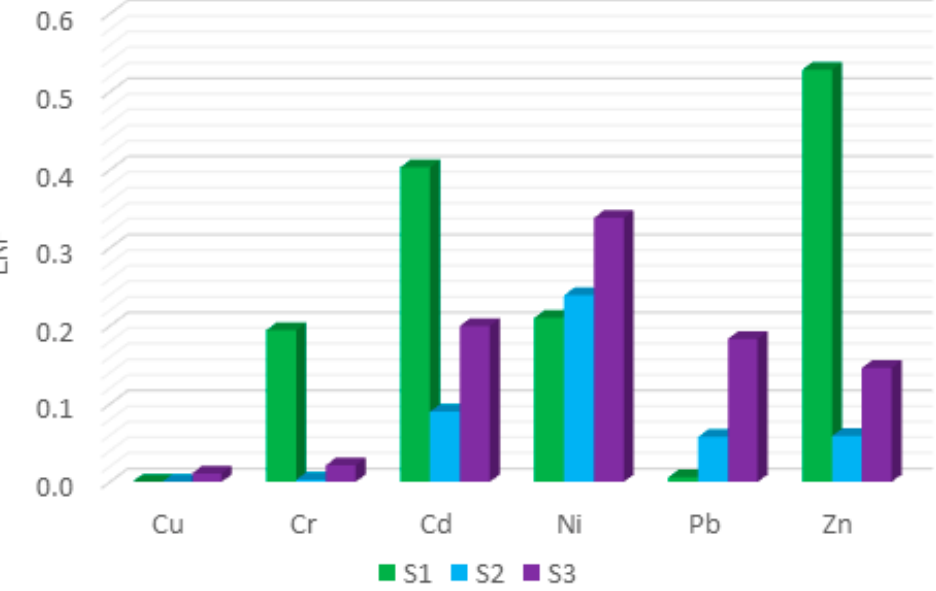
Figure 5. The environmental risk factor (ERF) of HMs in SS.